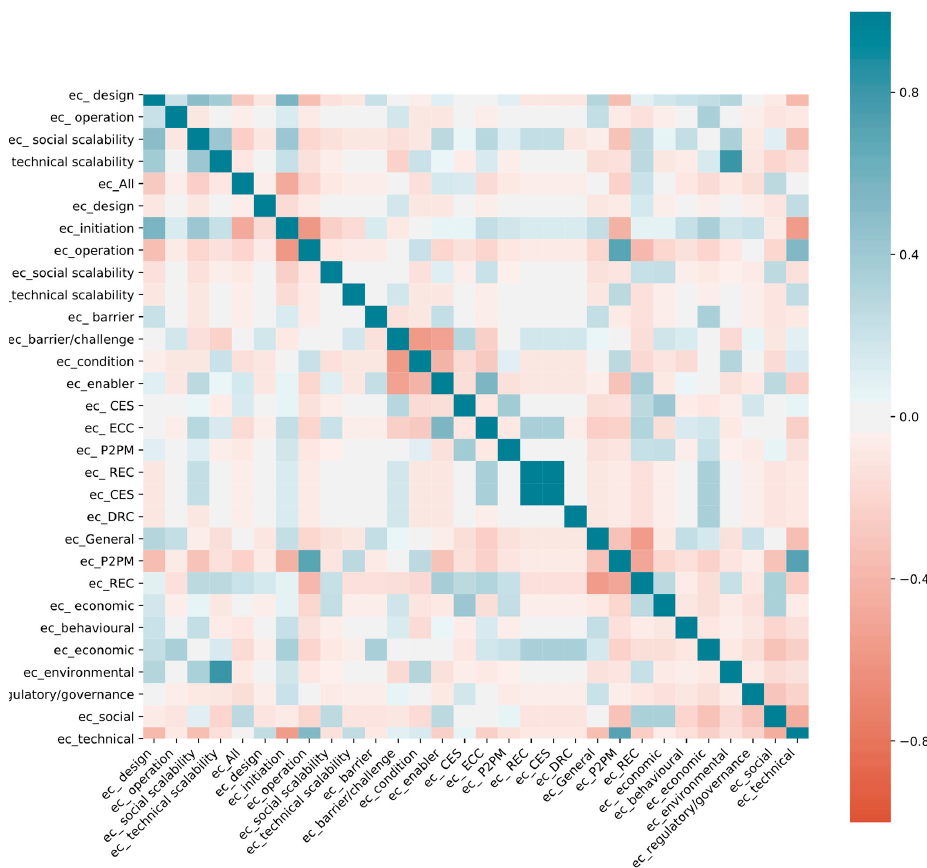
Figure 19. Pairwise correlation of metadata. Colder colour indicates a category consistently appearing together for progression factors. Table 9. Top 5 pairwise correlates of metadata.